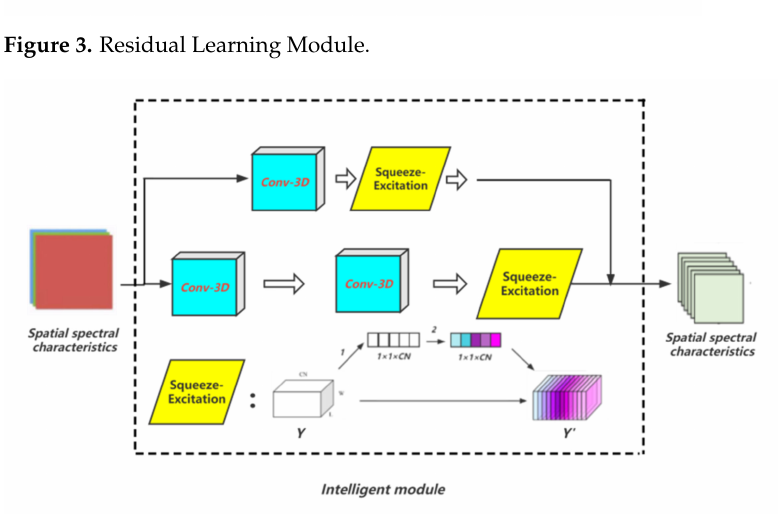
Figure 4. Structure diagram of intelligent